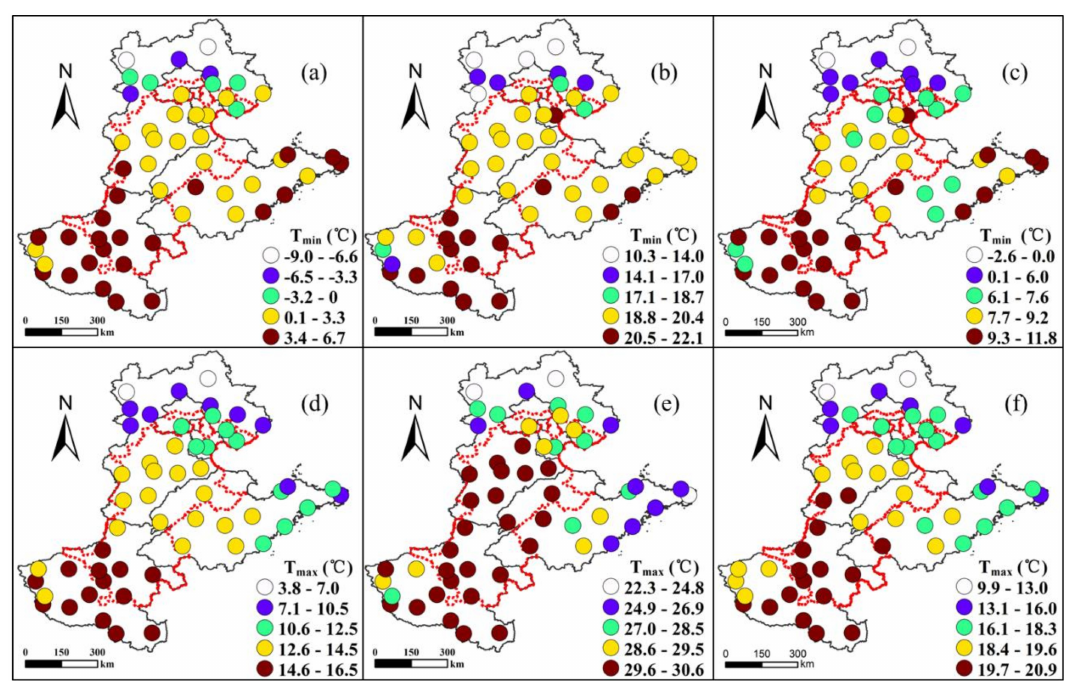
Figure 2. The spatial distribution of ( a – c ) long-term average minimum air temperature (T min ) and ( d – f ) maximum air temperature (T max ) on the winter-wheat growing season, summer-maize growing season, and annual